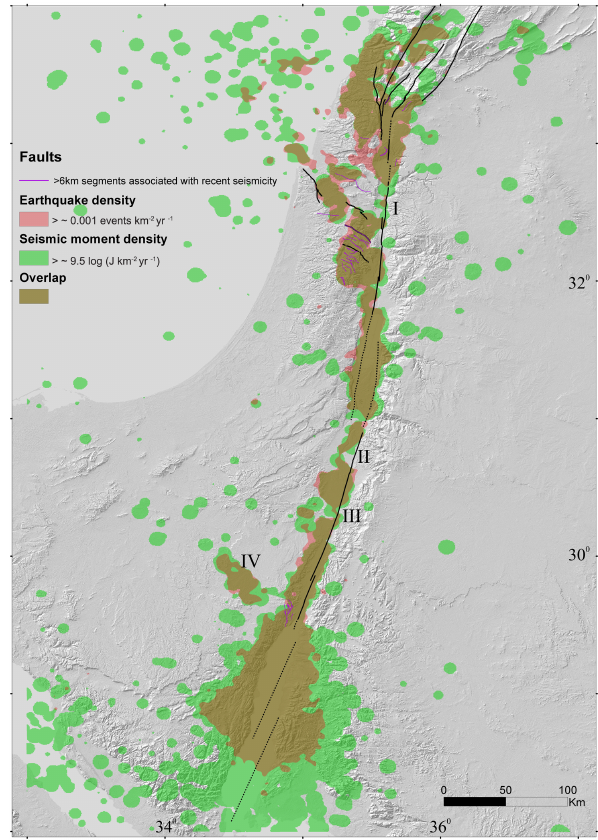
Figure 6. The seismicity polygons: earthquake kernel density of values > ∼ 0 . 001eventskm − 2 yr − 1 and M 0 kernel density of val- ues > ∼ 9 . 5log(Jkm − 2 yr − 1 ); the product is the overlap polygon (in